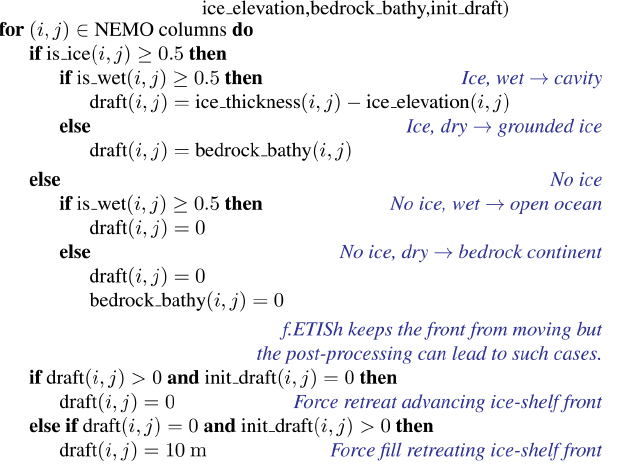
Figure A2. Pseudocode for the ice-sheet geometry post-processing. “ conserv_interp ” is a conservative interpolation from f.ETISh’s grid to NEMO’s. On the f.ETISH grid, “is_ice” is 0 for the open-ocean column, else (cavity or grounded ice) it is 1; “is_wet” is 0 for grounded ice, else (cavity or ocean) it is 1. “draft” is the ice-shelf draft; like the bedrock bathymetry, it is positive downwards and set to zero at the ocean surface. “ice_elevation” is the ice surface elevation compared to floating point level, defined positive upwards. “init_draft”, the initial NEMO ice-shelf draft, is used to ensure that the procedure has not led to ice-shelf front displacement.